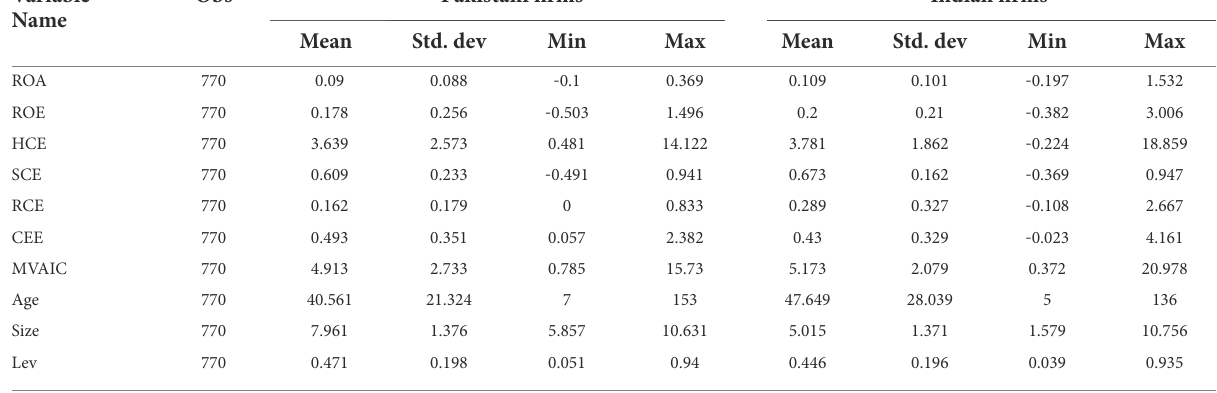
Table 2 Descriptive statistics.